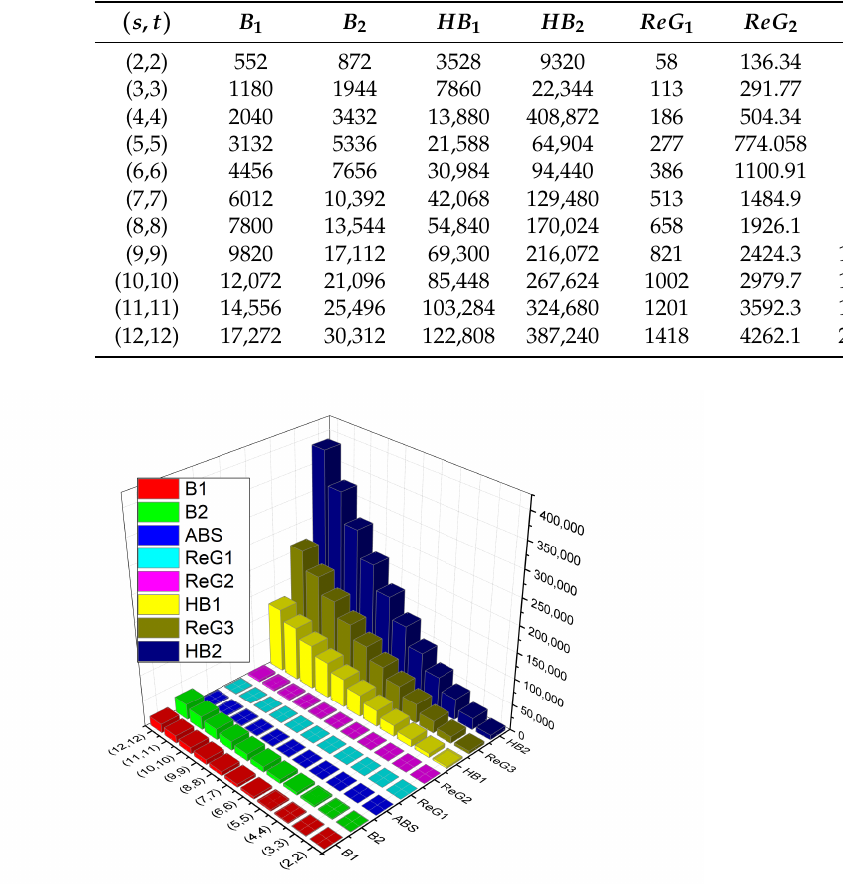
Figure 2. Graphical comparison of TI’s of NbO 2